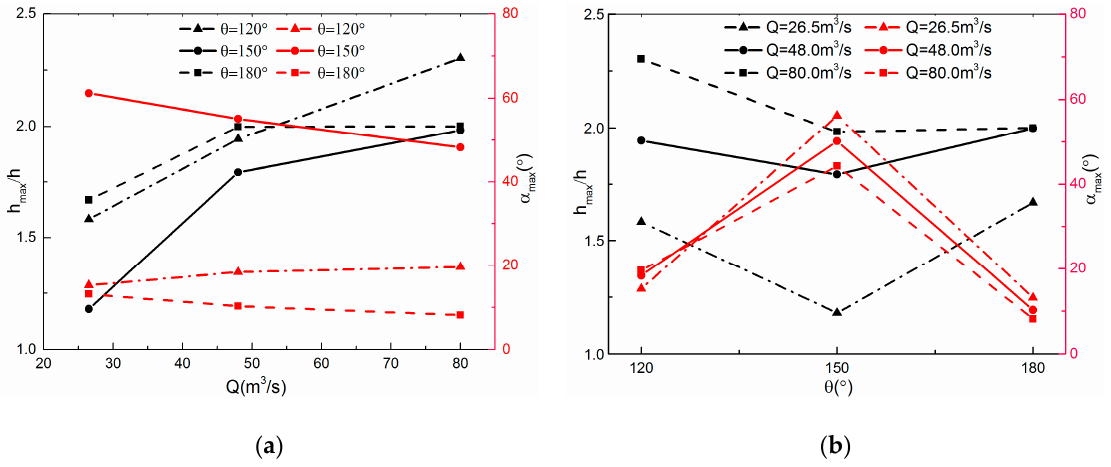
 and Q and ( b ) the